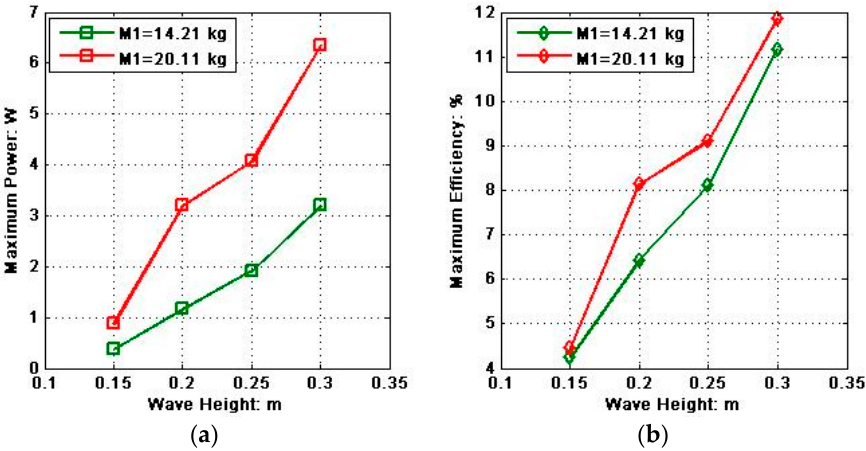
Figure 19. Comparation of generation performance of the ACWEC with different masses of M 1 : ( a ) the maximum power curve; ( b ) the maximum efficiency curve.